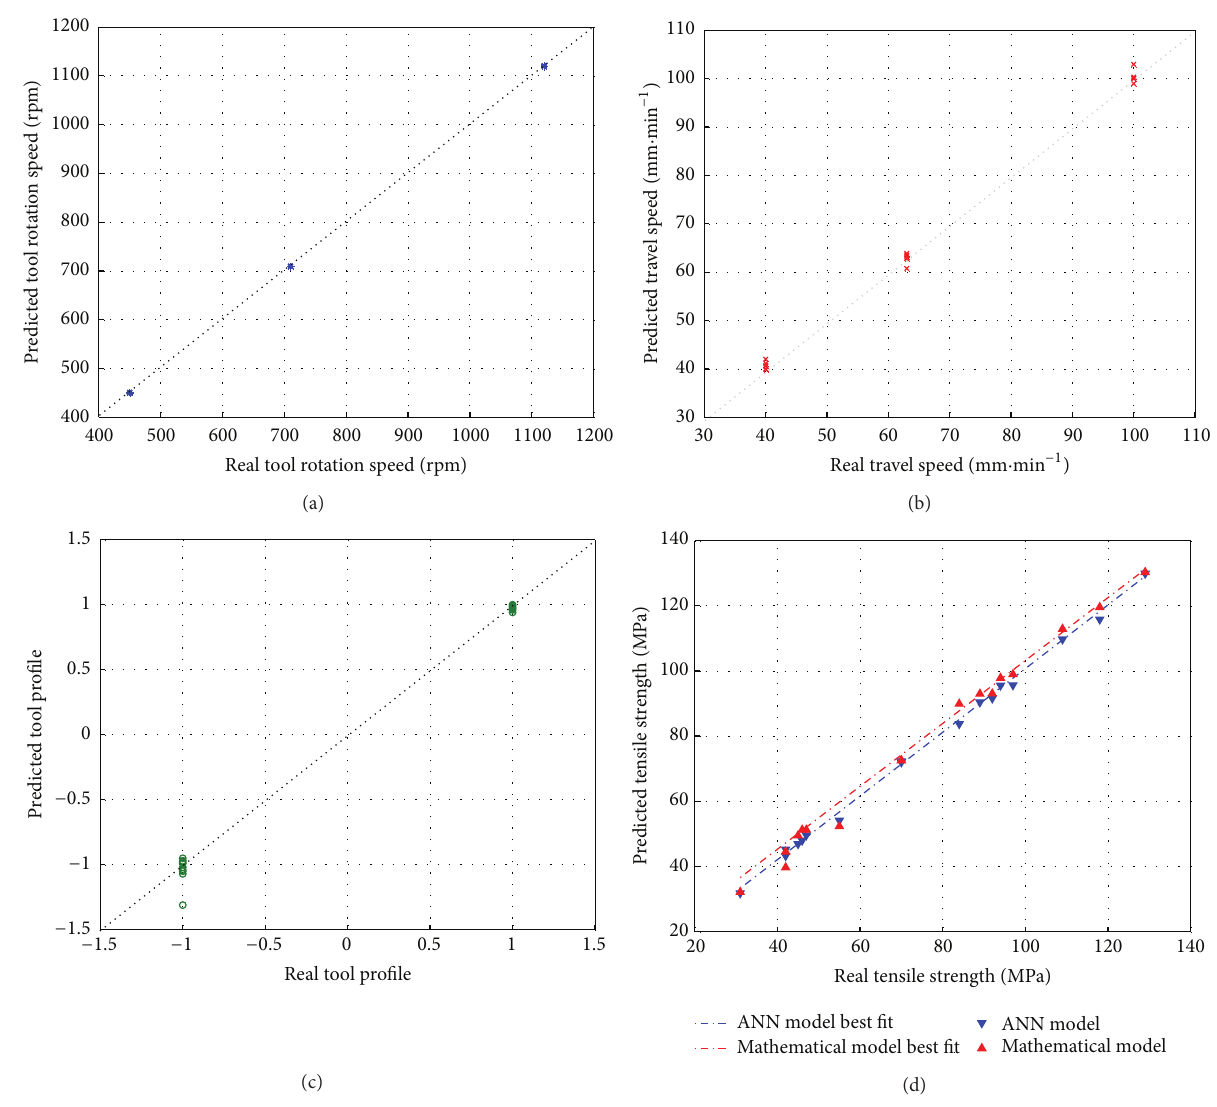
Figure 8: Predicted and measured process parameters. (a) Tool rotation speed, (b) travel speed, (c) tool profile, and (d) tensile